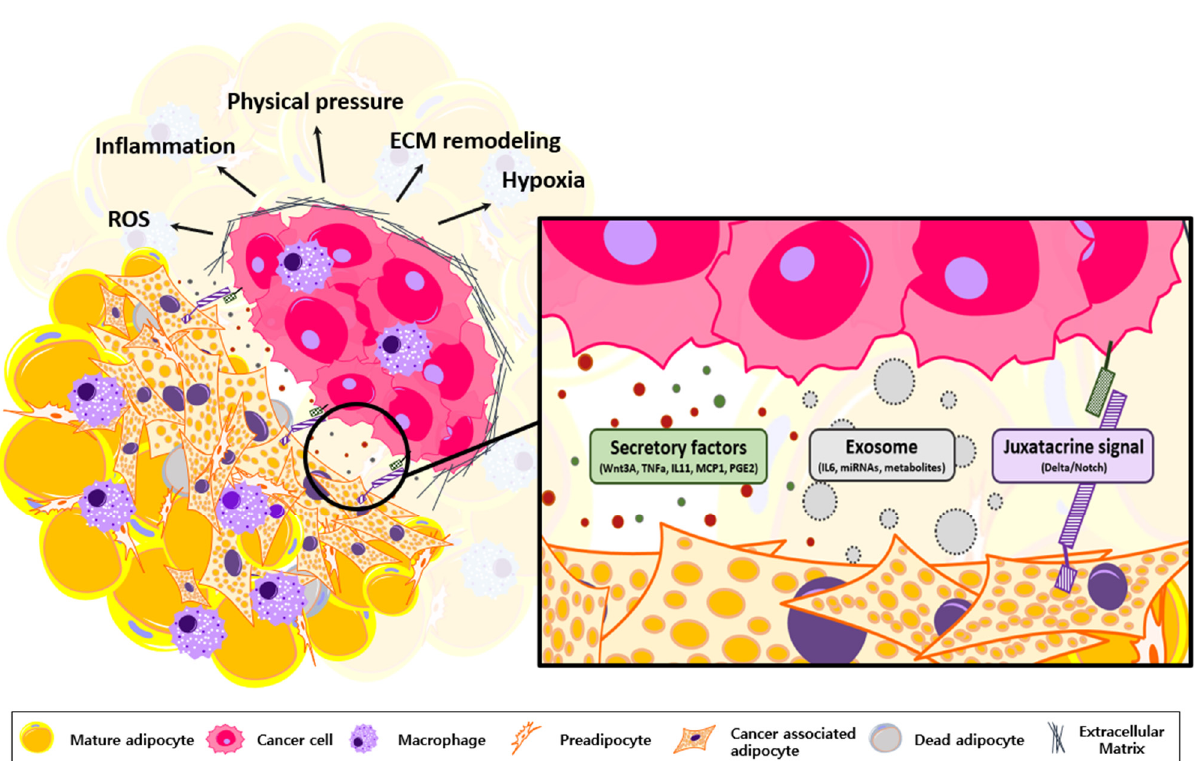
Figure 3. Generation of Cancer-Associated Adipocyte. Tumor cells exchange diverse signals with TME compartments to construct a favorable environment. In the adipose-rich environment, adipocytes undergo a transformation when influenced by cancer-derived secretory factors. Cancer cells and adipocytes also communicate via exosomes, which contain pro-inflammatory factors, miRNA, and metabolites. Juxtacrine signal also activates Notch signaling of adipocytes to initiate dedifferentiation. Abbreviation: TME, tumor microenvironment; ROS, reactive oxygen species; TNF ɑ , tumor necrosis factor ɑ ; IL-11, interleukin-11; MCP1, monocyte chemoattractant protein1; PGE2, prostaglandin E2.